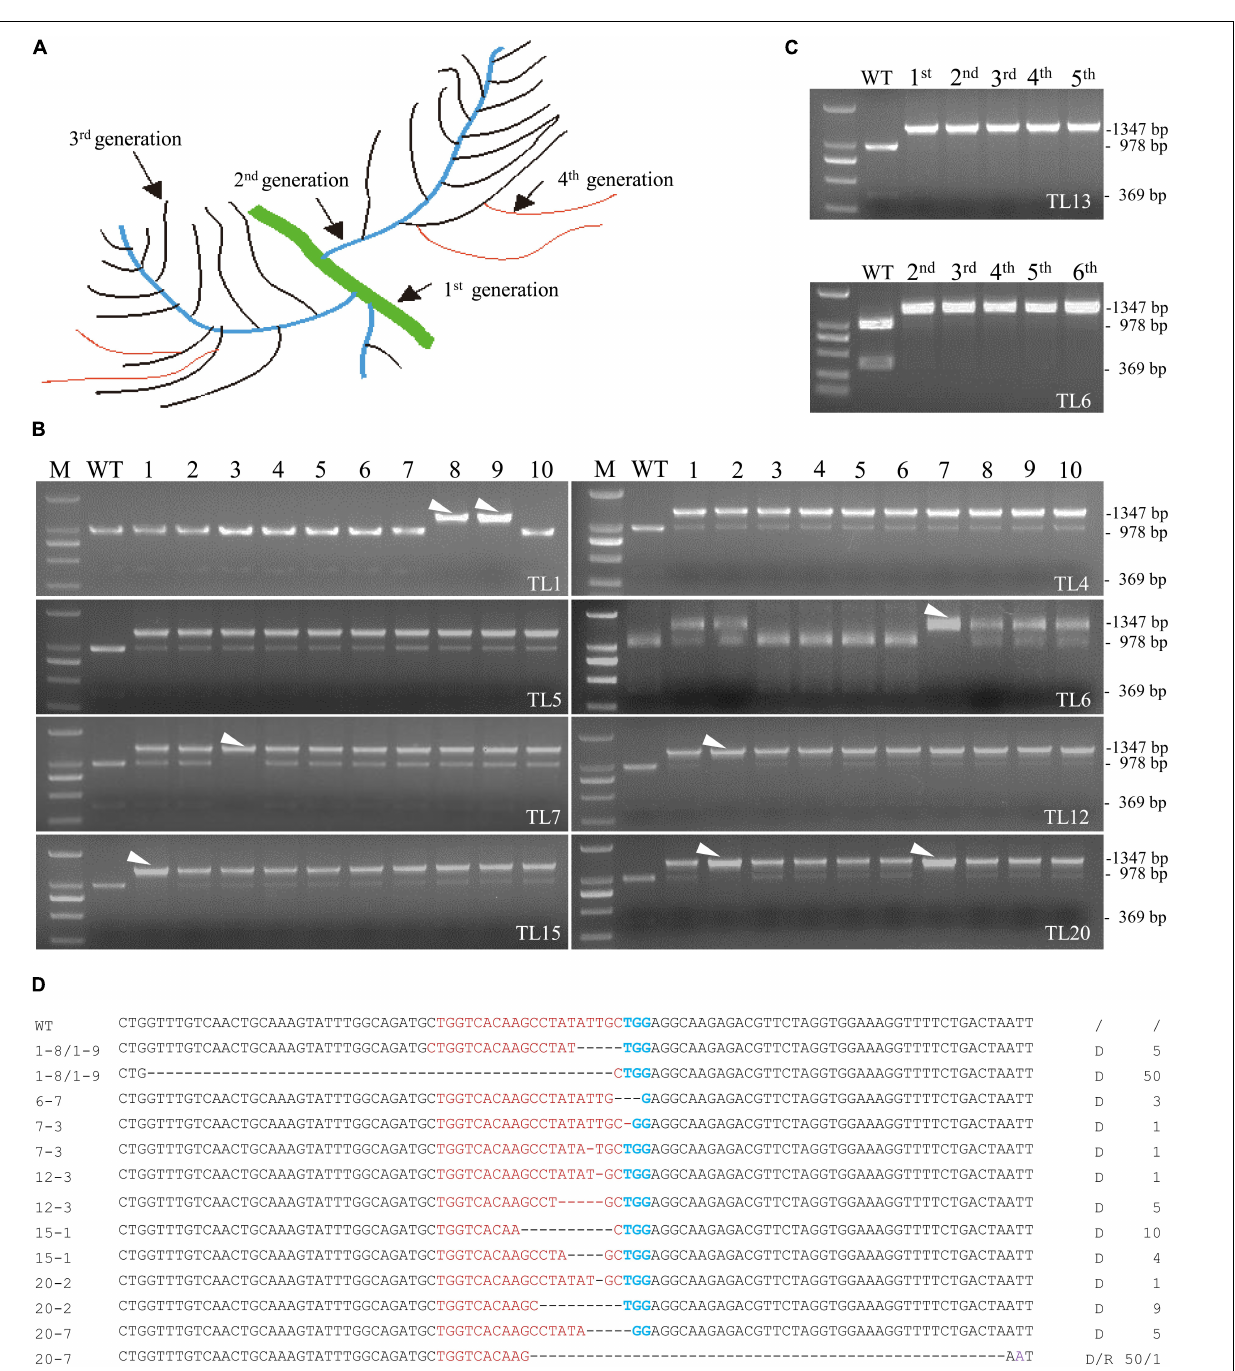
Frontiers in Plant Science |